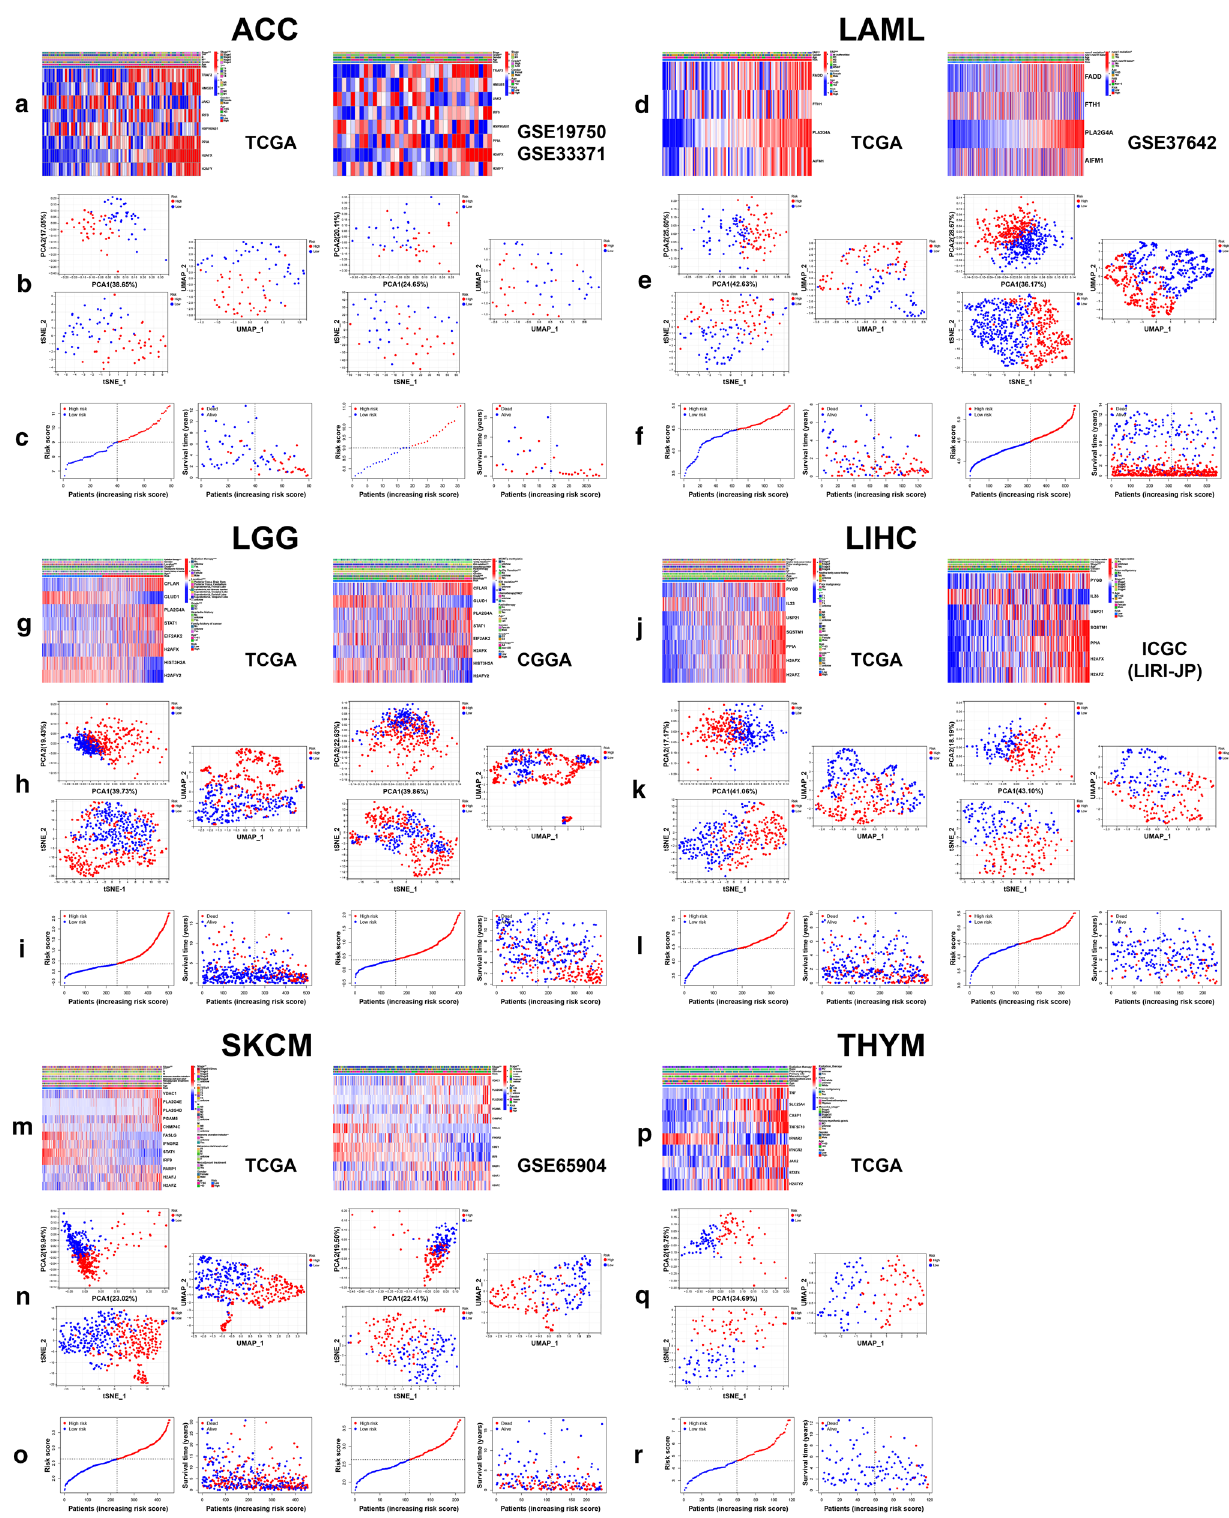
Fig. 6 Model genes expression, dimensionality reduction analysis and distribution of risk score and survival state. The heat maps ( a , d , g , j , m , p ) showed the variation trend of model genes expression with the increase of risk score and the comparison of several clinical factors between low- and high-risk groups in the six selected cancers. Fisher’s exact test was used. *p < 0.05; **p < 0.01; ***p < 0.001. Principal Component Analysis (PCA), t-distributed Stochastic Neighbor Embedding (t-SNE) and Uniform Manifold Approximation and Projection (UMAP) ( b , e , h , k , n , q ) confirmed the stratification of patients into low- and high-risk clusters. The scatter diagrams ( c , f , i , l , o , r ) showed the condition of patients’ risk score and distribu- tion of their survival time and state, with dotted line separating patients into low- and high-risk